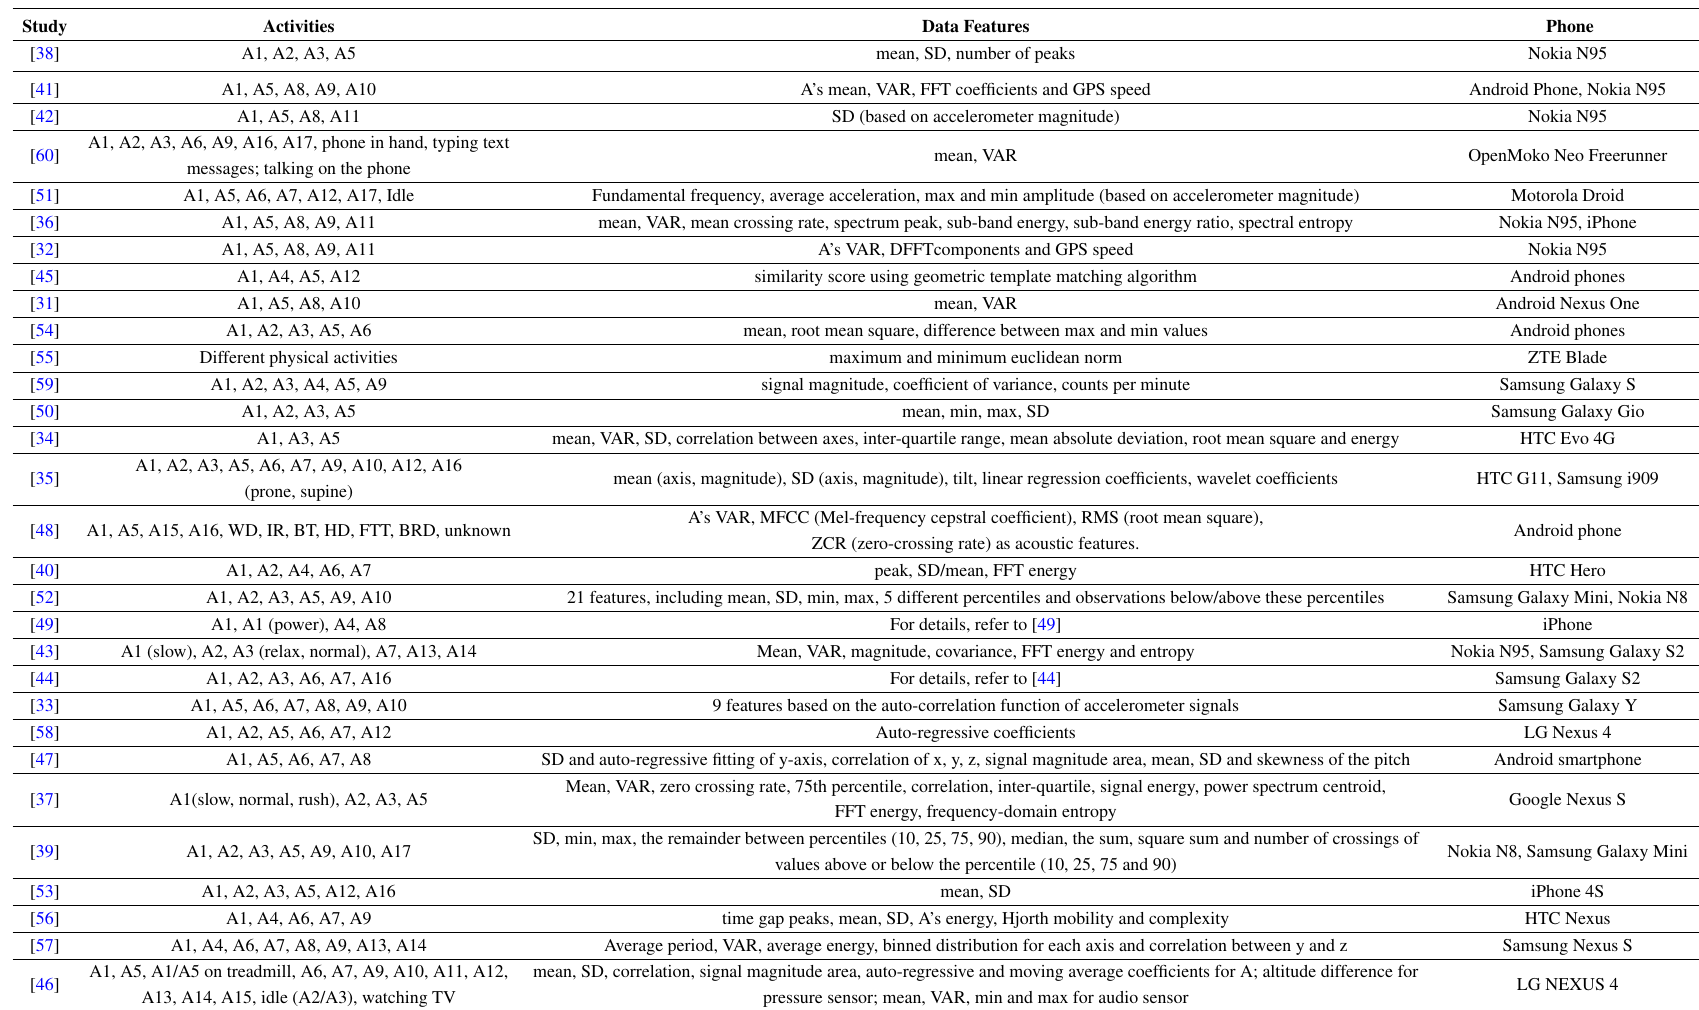
Table 3. Phones, activities and data features used in online activity